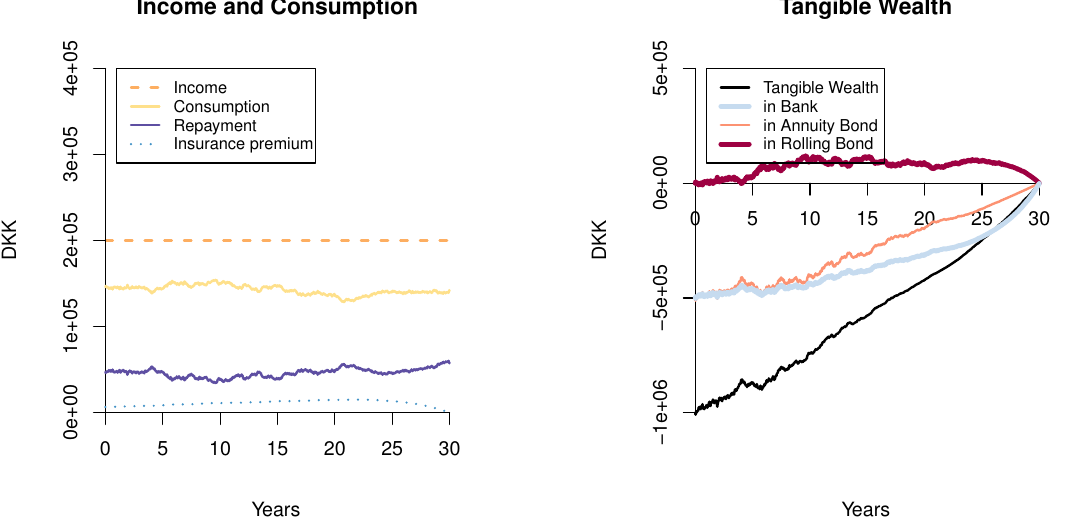
Figure 4. Investor and strategy identical to Figure 3, but with bond funding expressed as a constant FRM position in combination with a positive investment in the rolling